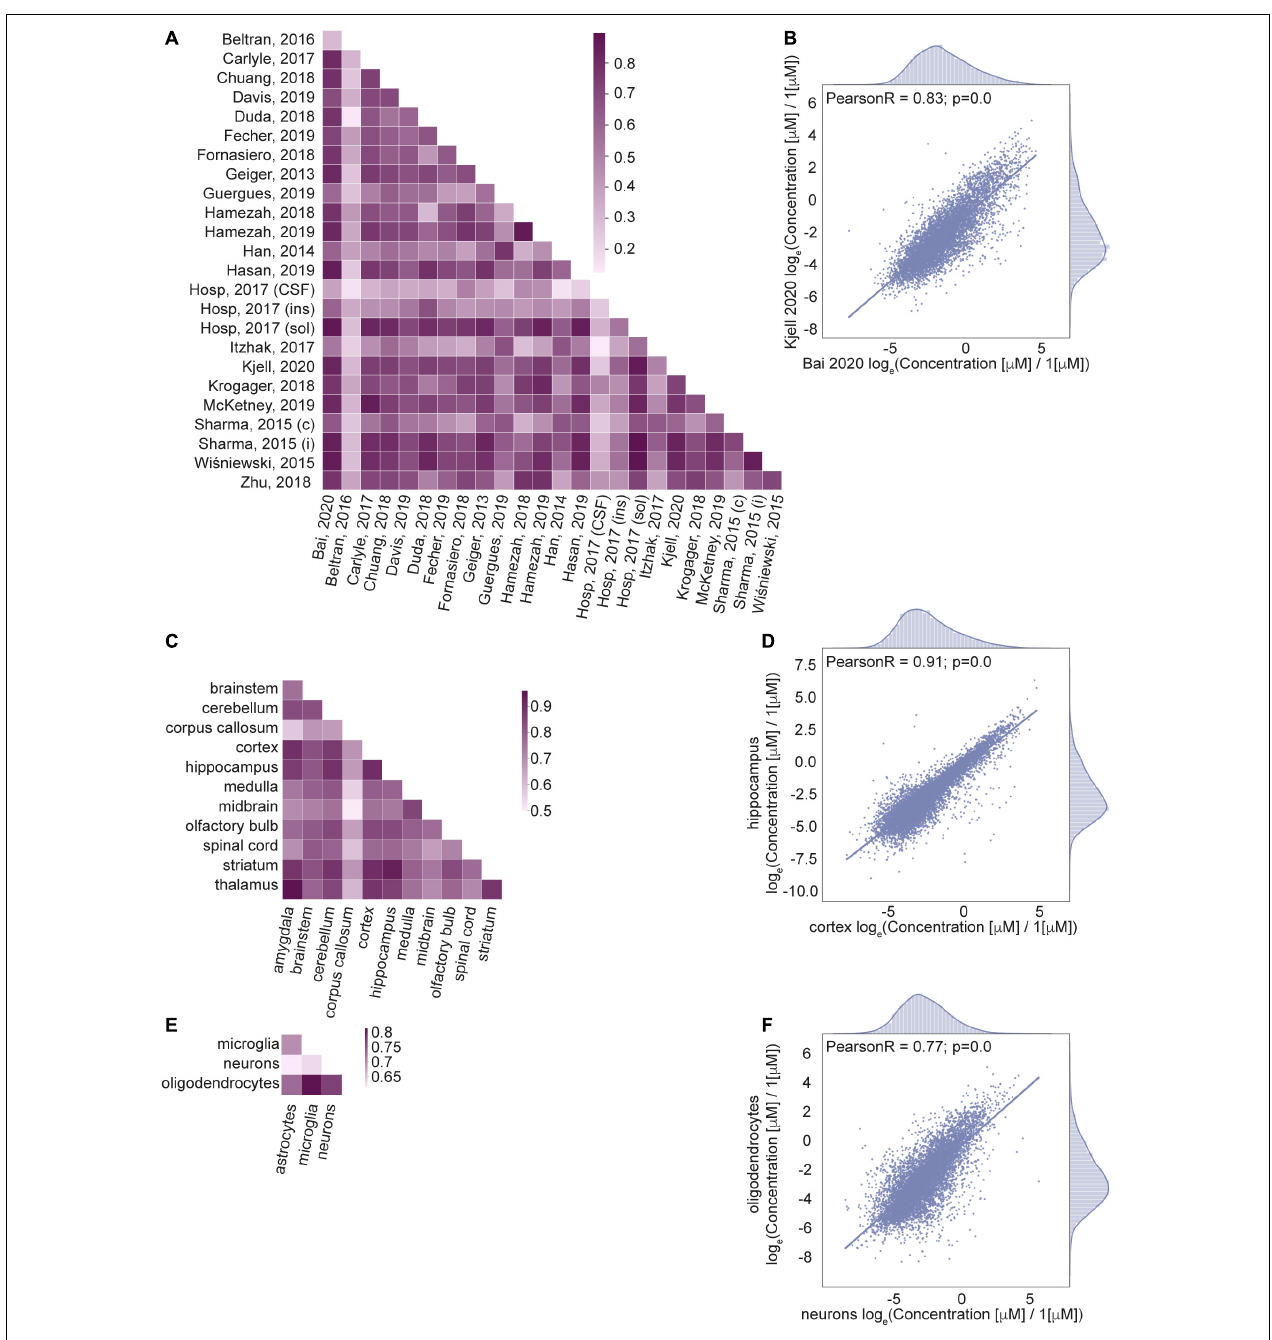
FIGURE 4 | Correlation of protein concentrations confirms good agreement of the integrated data. (A,C,E) Pearson coefficient of correlation for protein concentrations from different studies (A) , brain regions (C) , cell types (E) after normalization. (B,D,F) Representative examples for the comparison of protein concentrations data from two studies (B) , two brain regions (D) , and two cell types (F) . Natural logarithm for µ M concentrations is used in all